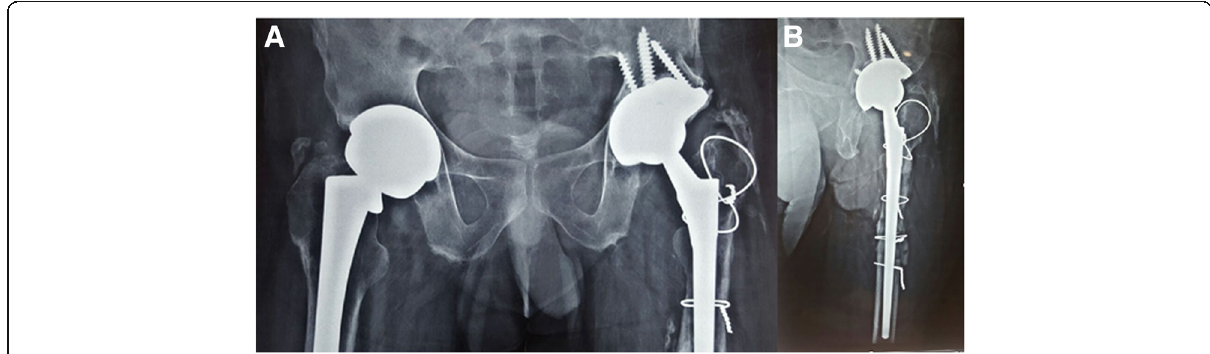
Fig. 3 Radiographs at 6 weeks following surgery, showing trochanteric and femoral wiring for extended trochanteric osteotomy, and the revised stem and cup on the left hip. a Anteroposterior view. b Lateral